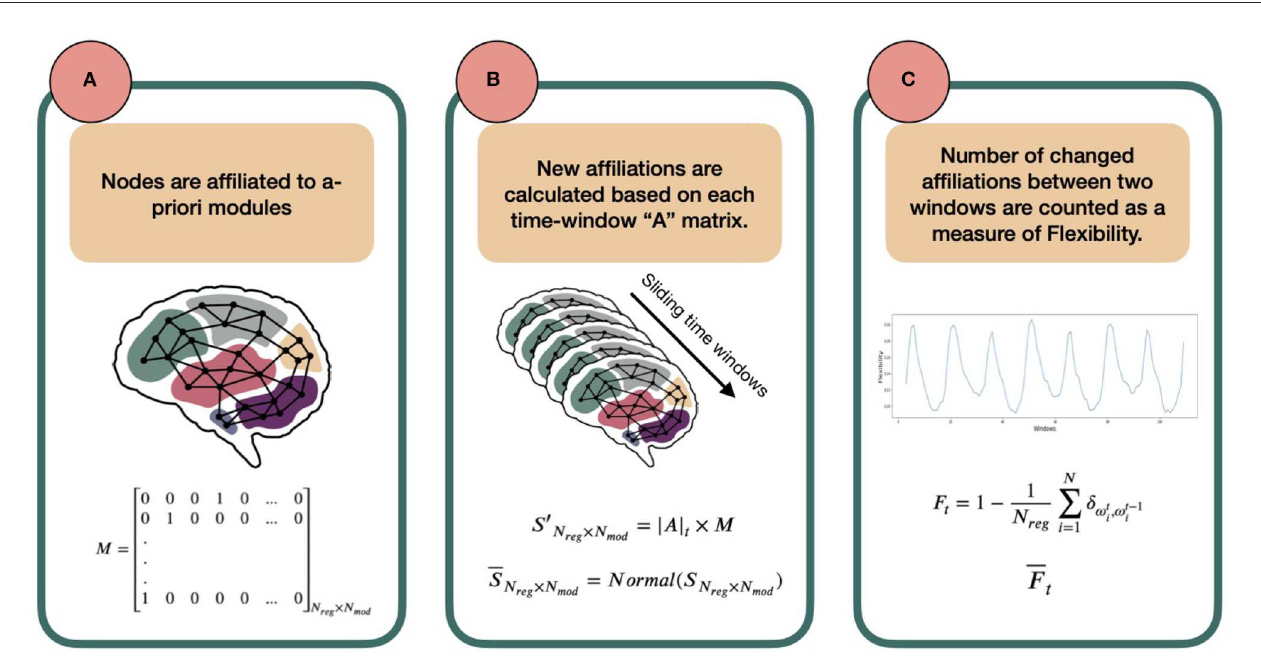
FIGURE1 Schematic overview of the template-based flexibility method. (A) Each node has an a-priori affiliation to a template module, not allowing overlap. In this paper, we use the Brainnetome atlas for node definition (Fan et al., 2016) and the FIND Lab network templates as predefined modules [http://findlab. stanford.edu/; Shirer et al., 2012]. Importantly, matrix M, describing the a-priori module affiliation for each node, is predetermined and serves as a reference. (B) Using a sliding-window approach, an adjacency matrix is constructed for each time window by calculating Pearson correlation coefficients between the time series of all possible pairs of nodes. Then, for each node and time window the reference module receiving the highest normalized connection weight will serve as the new modular affiliation for that node in that time window. (C) Last, the number of affiliation changes between affiliation vector in t and its successive vector in t + 1 is defined as the flexibility F t of the network between two time points. The average of F t across participants (called F t ) can be plotted for all consecutive time points (an example presented later in Figure